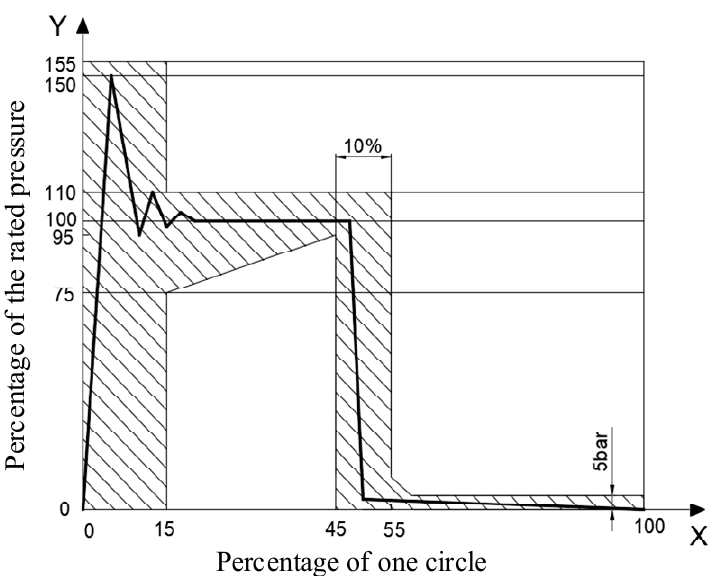
Figure 1. Standard water hammer wave.